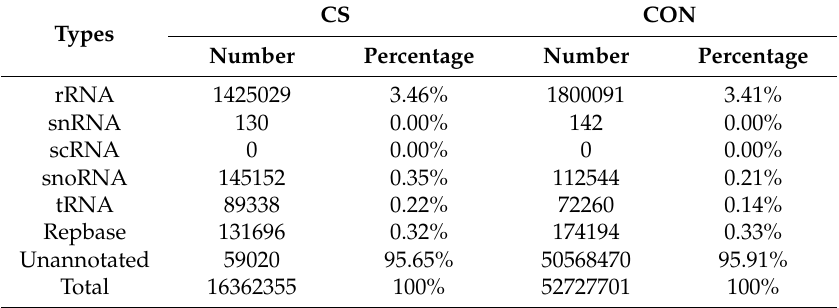
Table 6. Distribution of small RNA among di ff erently expressed categories in the library